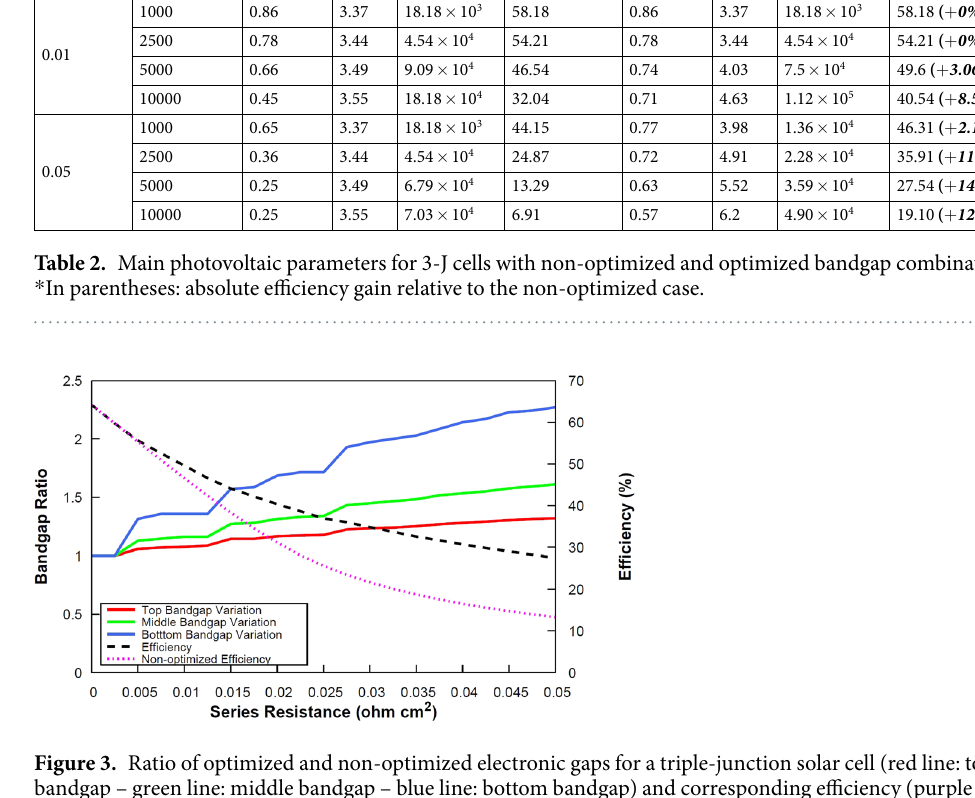
optimized MJ architectures), which, in turn, results in significant increase in FF and PCE values, since the voltage increase will compensate the decrease in the current value. Figure 3 depicts the ratio between the optimized and non-optimized bandgaps for a triple junction solar cell together with their associated conversion efficiency, as a function of the lumped series resistance value, and assuming a 5000 suns illumination level. The shift in both the optimized bandgaps and the associated conver- sion efficiency, relative to the “non-optimized” reference architecture, appears to grow steadily with increasing lumped series resistance value: if the benefit for bandgap optimization is modest for 0.01 Ω cm 2 cells (typ- ical state-of-the-art concentrator solar cell) with an absolute gain in efficiency of ~3%, we observe a strong improvement in the bandgap-optimized cell relative to the reference architecture for a series resistance value of 0.05 Ω cm 2 , with an absolute efficiency gain of ~15%. Figure 4 shows I - V curves for the 3 J cells operated under 5000 suns for a fixed series resistance scenario of 0.05 Ω cm 2 . Each graph includes different curves, showing the global electrical response of MJ cell (red curve) as well as the electrical response of each individual subcell (green, blue and black dashed curves) for a non-optimized (a) and optimized bandgap combination (b). The so-called “non-optimized I-V curves” correspond to the best combination for an ideal solar cell with zero series resistance under 1 sun intensity, namely 1.75/1.18/0.7 eV (top/ middle/bottom junction). The bandgap combinations for the optimized cases (i.e the ones leading to the highest conversion efficiency, accounting for the series resistance as well as the concentration ratio) were taken from Table 1. Figure 5 represents the variation of the short-circuit current density and the open-circuit voltage under 1 sun illumination, and for different combination of electronic gaps taken from Table 1. As the values of the electronic gaps involved in the stack increase, we observe a significant drop in the short-circuit current density, together with an increase in the open-circuit voltage: under high illumination levels, the balance between I sc and V oc is thus drastically changed relative to the reference case (i.e no series resistance losses), to diminish the detrimental effects of R s losses and increase the conversion efficiency. Fine-tuning of the bandgaps in the stack could thus potentially mitigate the effects of series resistance losses at high illumination levels. To better grasp the benefit of this approach, we represent the efficiency-concentration curves for a set of 3-J architectures whose bandgap combinations have been optimized for various illumination levels (from 1 to 10,000 suns) assuming a total series resistance of 0.01 Ω cm 2 (Fig. 6) and 0.05 Ω cm 2 (Fig. 7). For